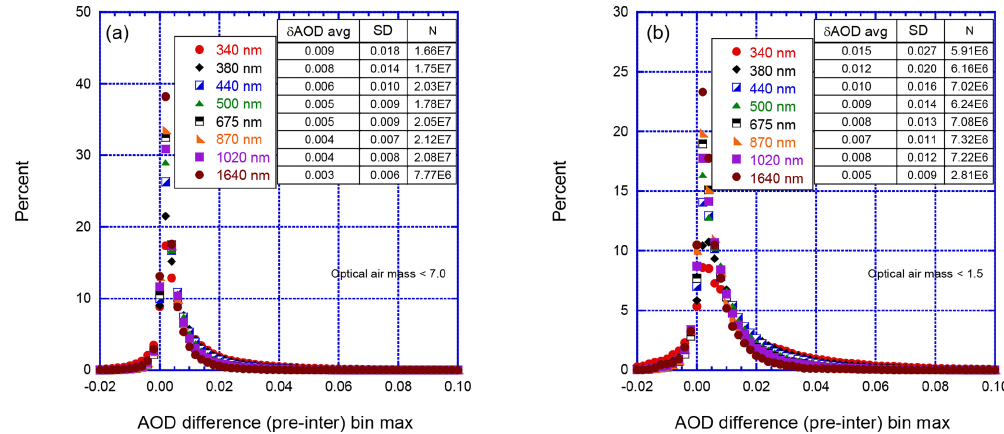
Figure 19. Using data qualified as Version 3 Level 2.0, aerosol optical depth (AOD) average difference comparing measurements only with the pre-field calibration applied versus instruments with both the pre-field and post-field calibrations applied from 1993 to 2018. Calibration sites are excluded from the analysis. The histogram of AOD differences is provided for the optical air mass 1 . 0 ≤ m < 7 . 0 range in (a) and 1 . 0 ≤ m < 1 . 5 range in (b) . The average difference is largest for the UV wavelengths and smallest for the longer